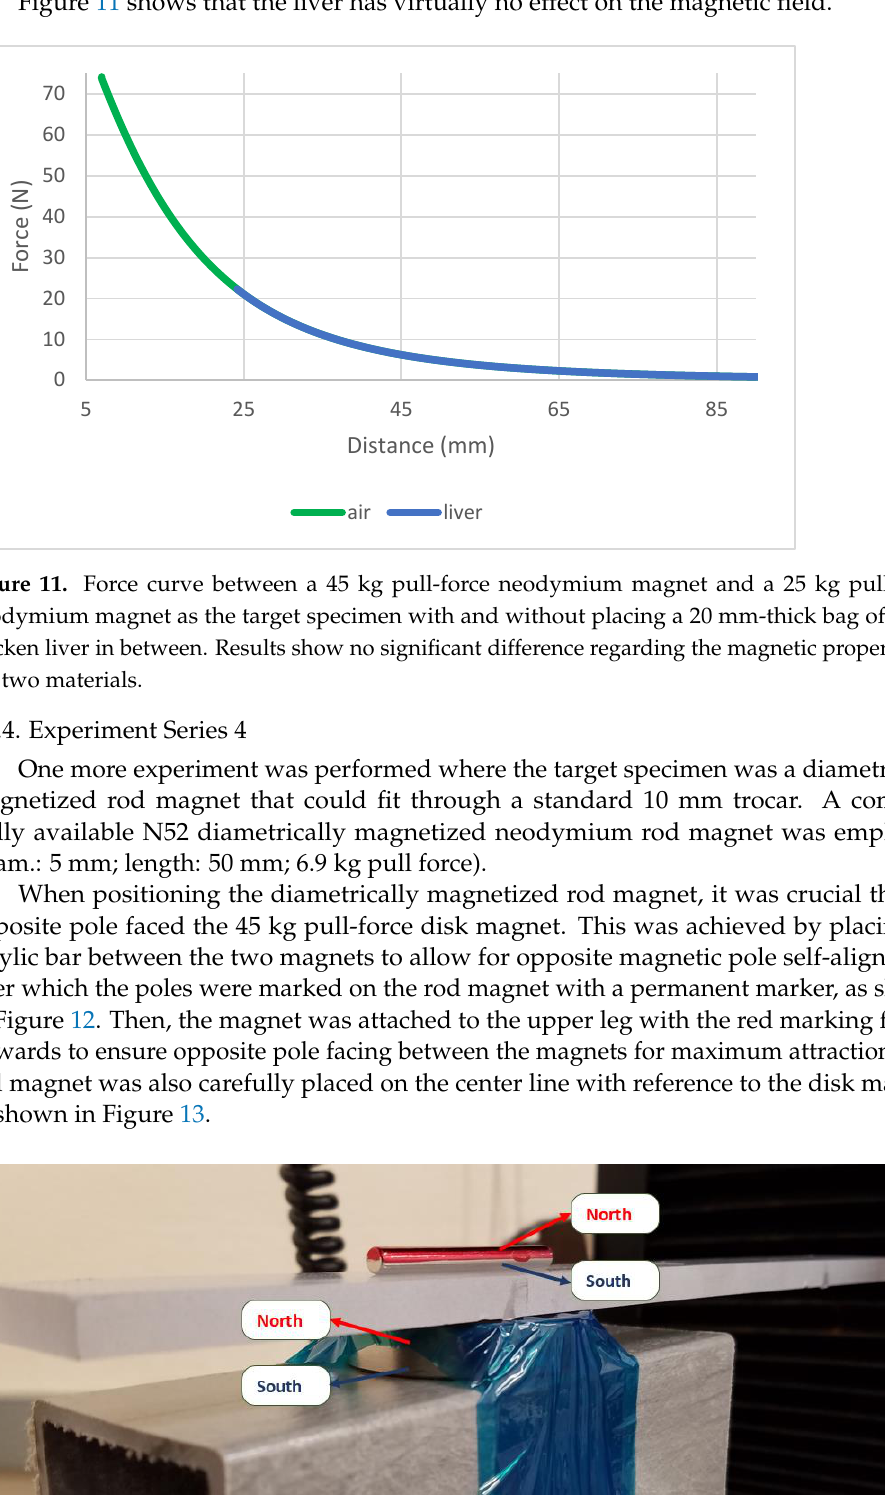
Figure 10. Experimental setup with a 45 kg pull-force neodymium magnet, a 25 kg pull-force neo- dymium magnet as the target specimen, and a 20 mm-thick bag of diced chicken liver in between.